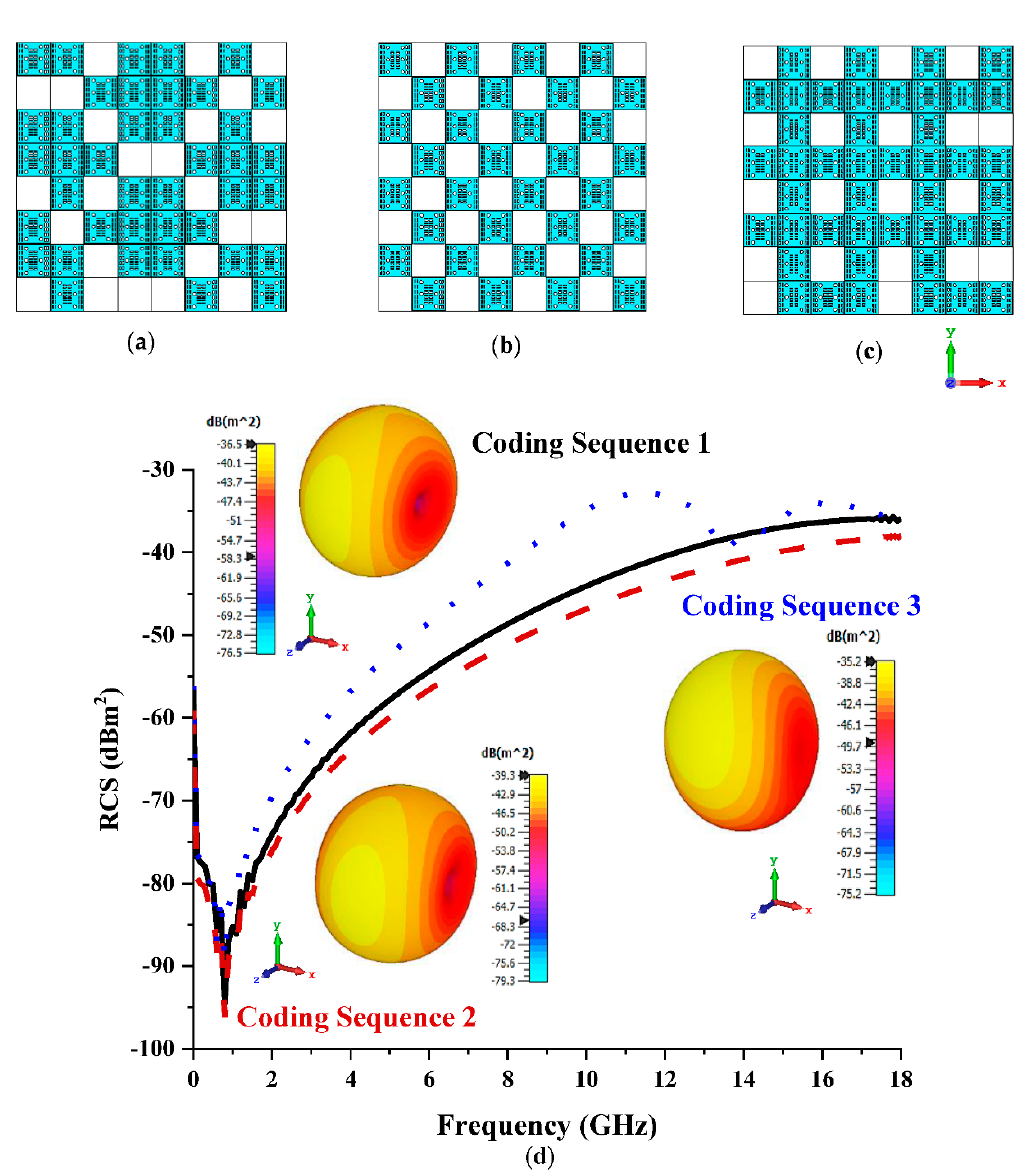
Figure 3. Eight lattices: ( a ) Coding Sequence 1; ( b ) Coding Sequence 2; ( c ) Coding Sequence 3; ( d ) monostatic RCS and bistatic scattering pattern at 15 GHz.